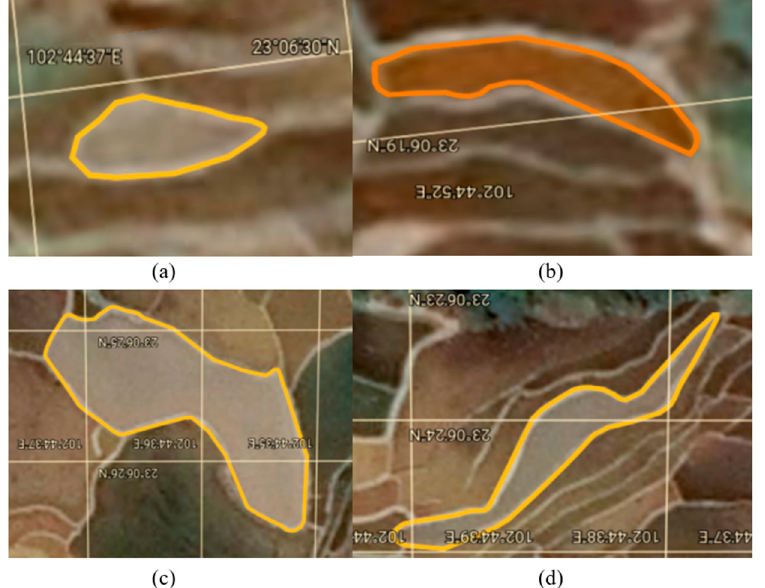
algorithm evolutionary hybrid neighborhood search algorithm) and the boundary polylines